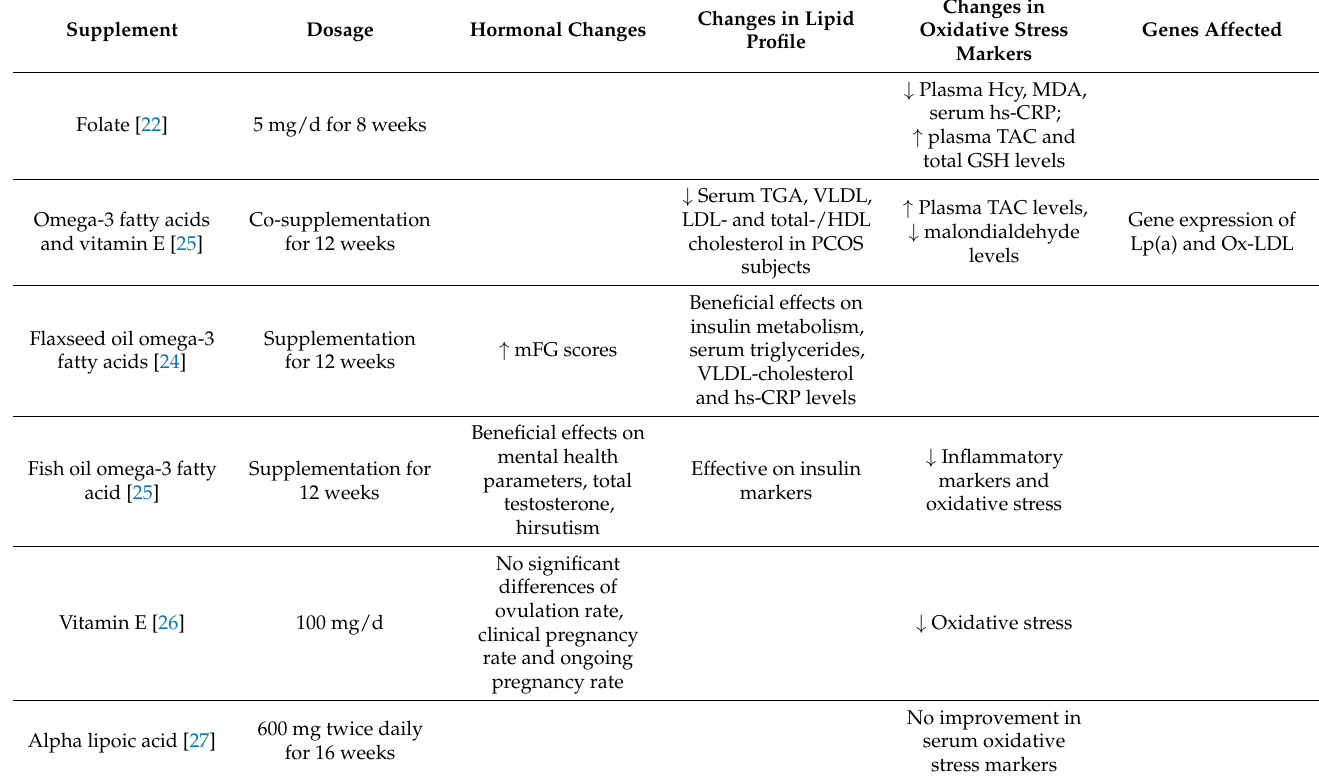
Table 2. Effect of supplementation on clinical and laboratory features in human